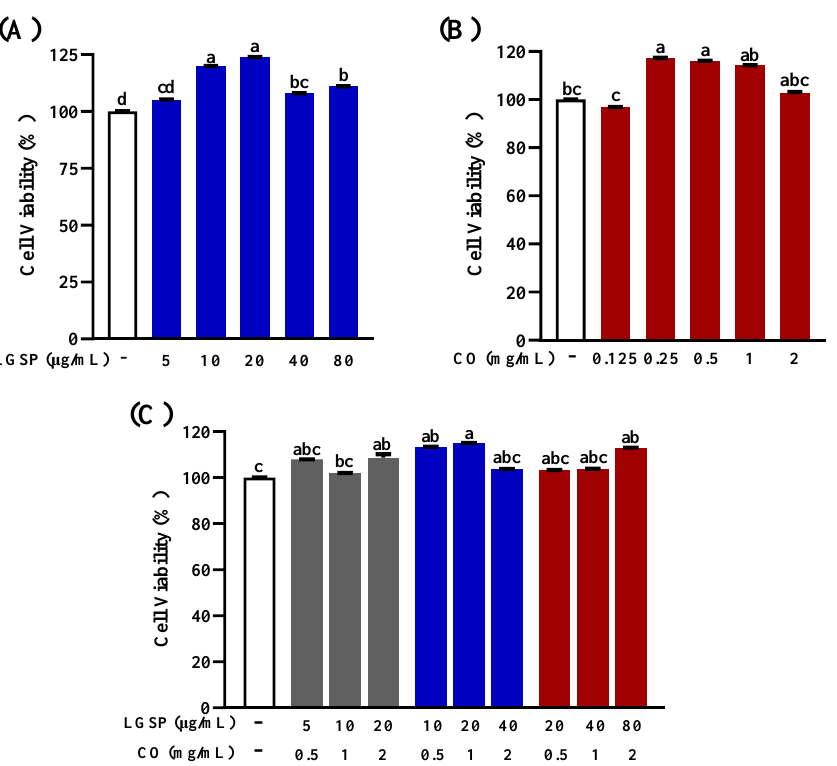
Figure 1. Effect of LGSP ( A ), CO ( B ) and their combination ( C ) on viability of RAW264.7 cells. All values are means ± SD, n = 3. Different letters above the bars indicate significant differences ( p < 0.05).